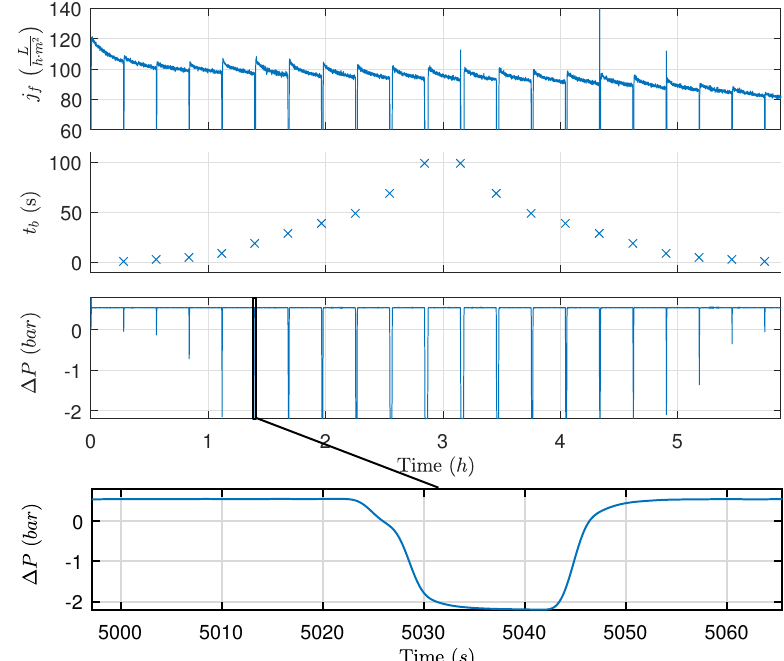
Figure 5. Experiment with different backwashing durations to identifying backwashing behavior.